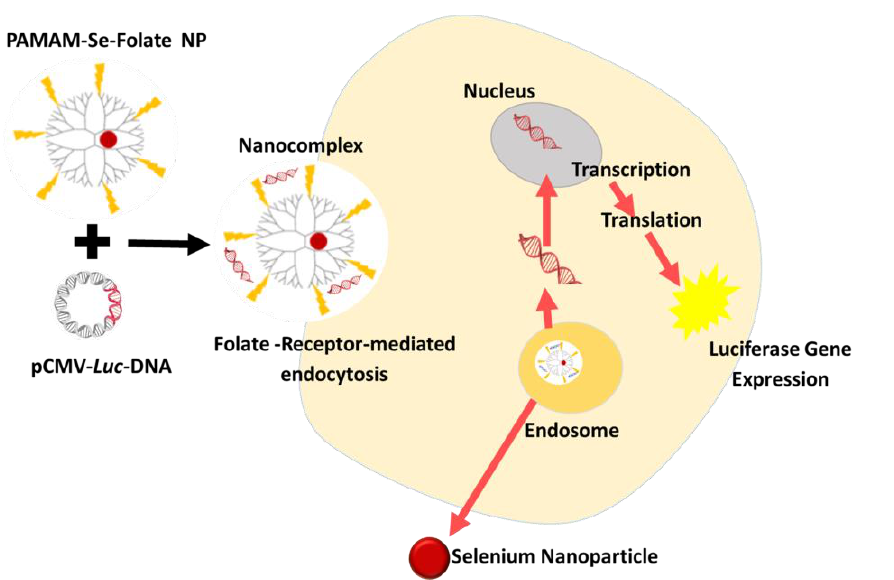
Figure 6. A representation of the delivery and transgene expression of pCMV -Luc DNA using folate- targeted, PAMAM-functionalized selenium nanoparticles. Reproduced from [34], MDPI, 2020.